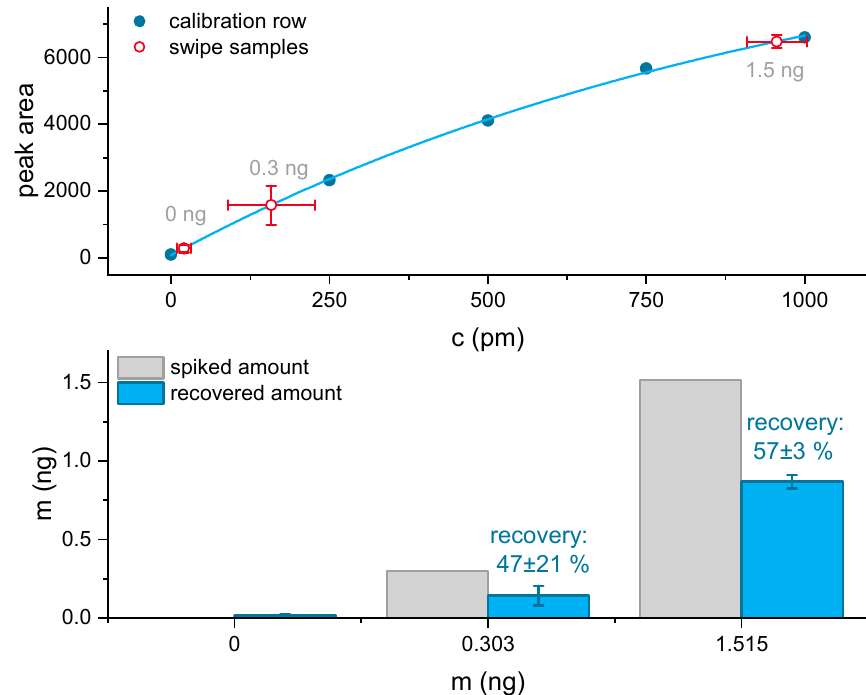
Figure 10. Calibration from 250 to 1000 pM cocaine based on the peak area with an asymptotic fit. The mean and the standard deviation of the 0, 0.3, and 1.5 ng triplicate samples were highlighted ( top ). Comparison of the spiked amount of cocaine to the amount of cocaine (recovery) determined by the wipe test based on the peak areas ( bottom ).